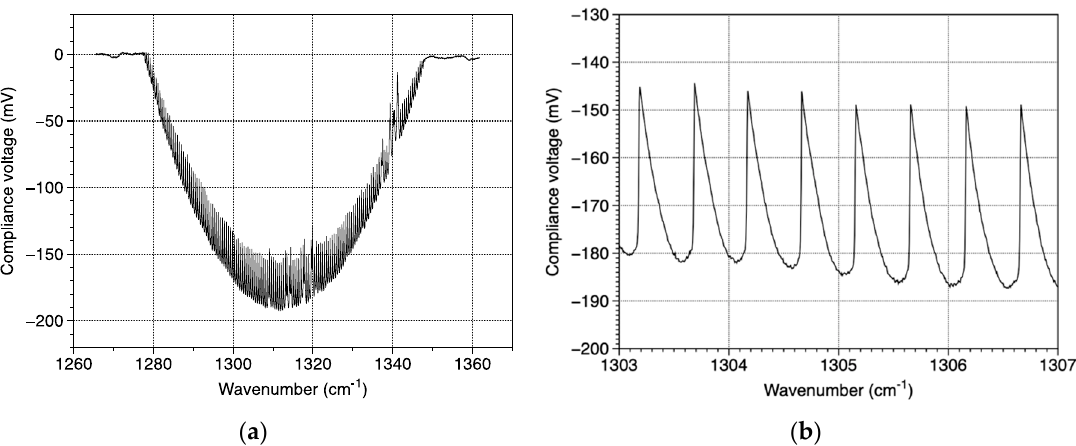
Figure 10. ( a ) QCL device compliance voltage when varying the mirror angle ±3° and ( b ) a zoom on Figure 10a around 1305 cm − 1 .